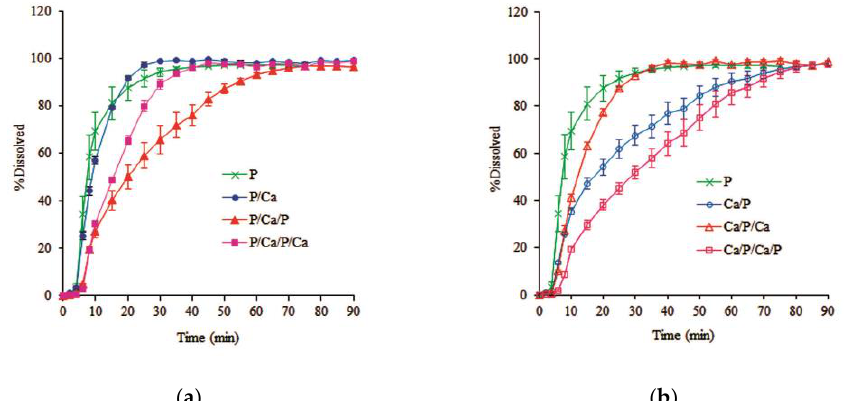
Figure 8. Effect of the coating quantity and sequence on the dissolution profiles of alternate layer